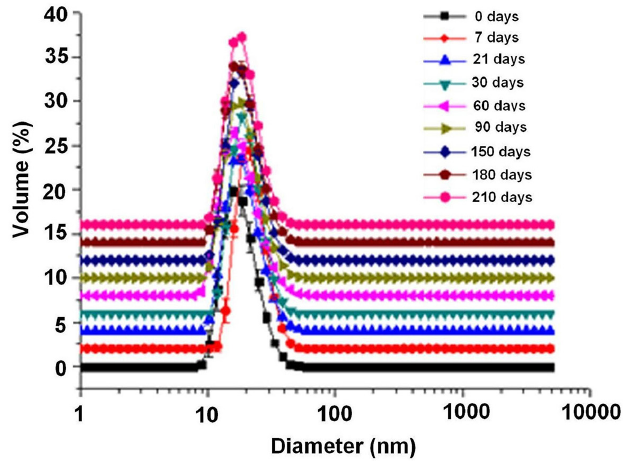
FIGURE 2 - Droplet size distribution profile of the nanoemulsion obtained during the stability study (0, 7, 21, 30, 60, 90, 150, 180 and 210